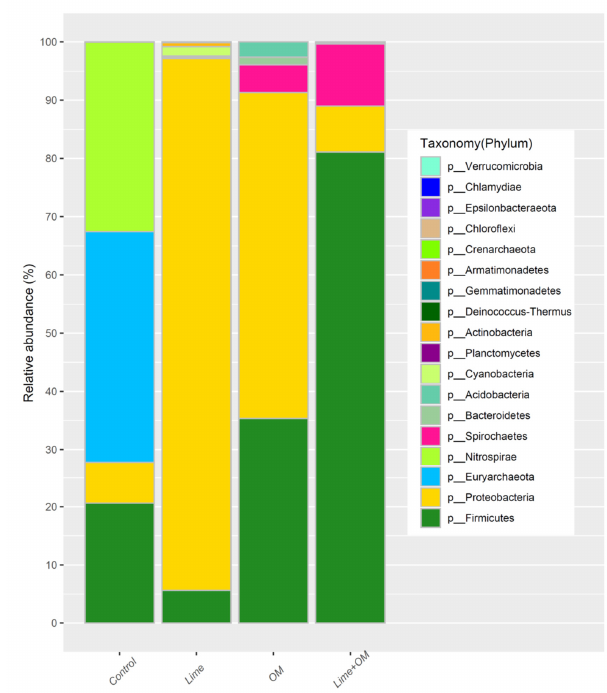
Figure 5. Phylum of the microbes in the residue of the four columns (control, Lime, OM, and Lime + OM) at the end of the inoculation of 180 days. Int. J. Environ. Res. Public Health 2020 , 16 , x